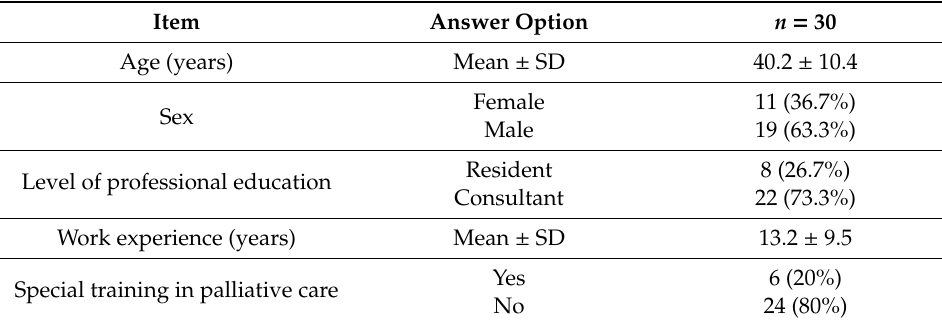
Table 1. Demographic data of the consensus experts.